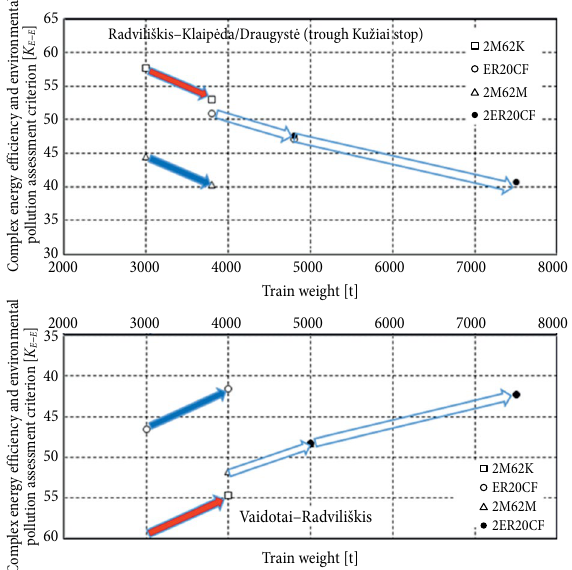
Fig. 6. Evaluation of energy efficiency on freight transportation line Vaidotai–Radviliškis–Klaipėda/Draugystė (via Kužiai station)